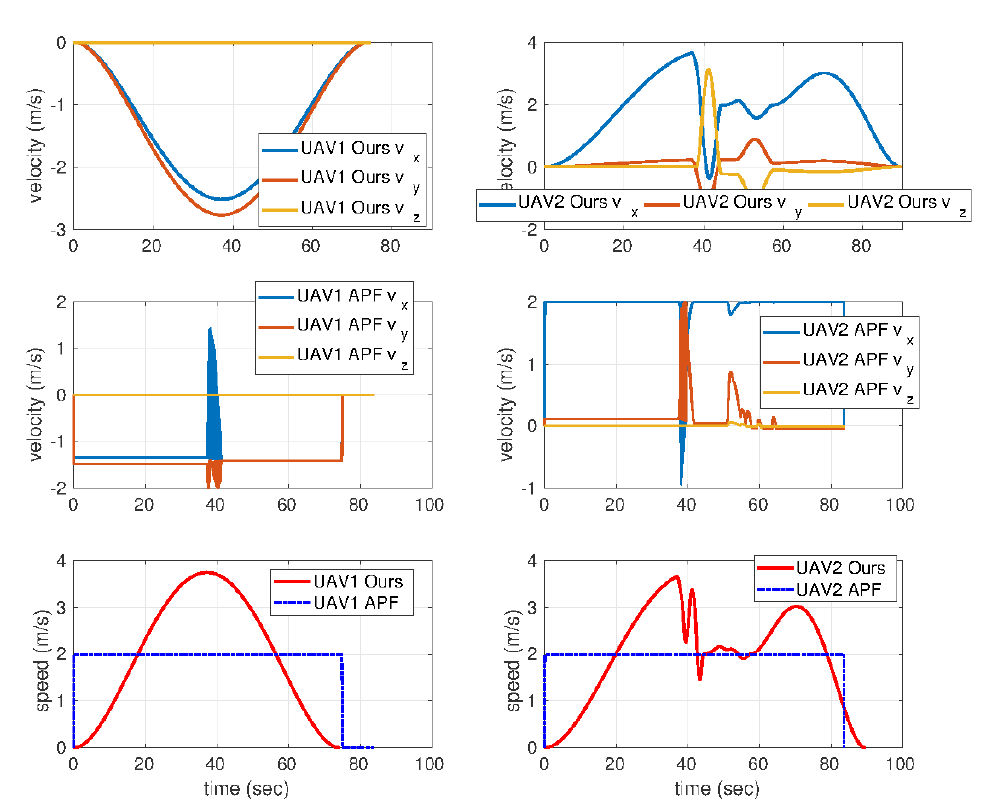
Figure 21. Linear velocity and speed of the complex environment